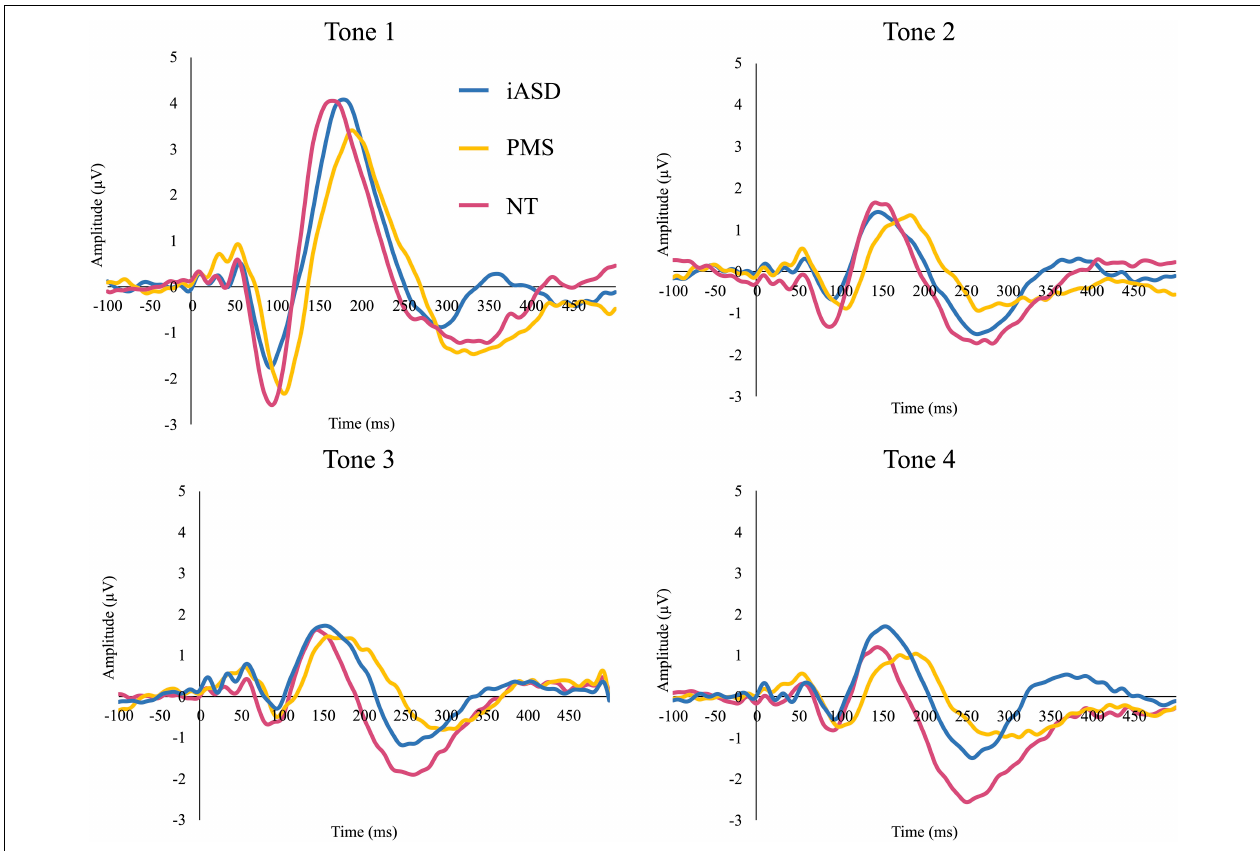
FIGURE 1 | Event-related potentials (ERP) response to consecutive four tones in individuals with idiopathic ASD (iASD), Phelan-McDermid Syndrome (PMS), and neurotypical development (NT) groups.